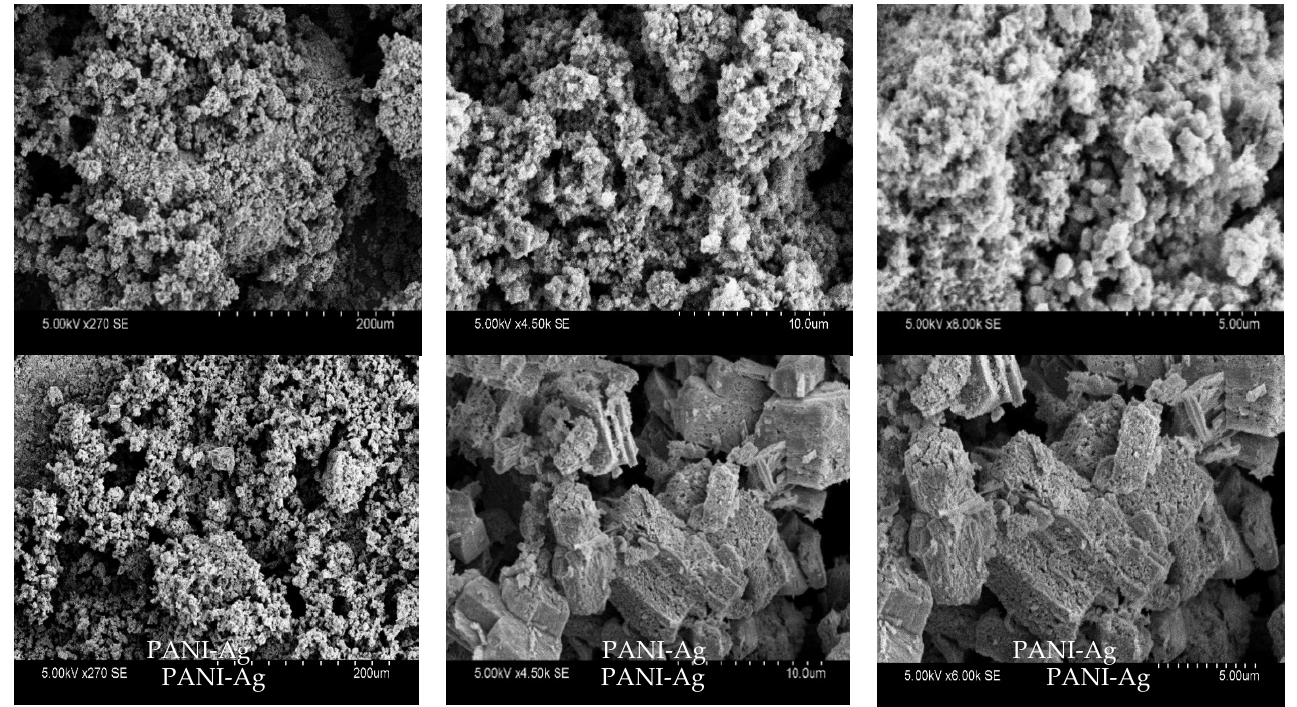
Figure 4. SEM images of PANI and the PANI-Ag composite.